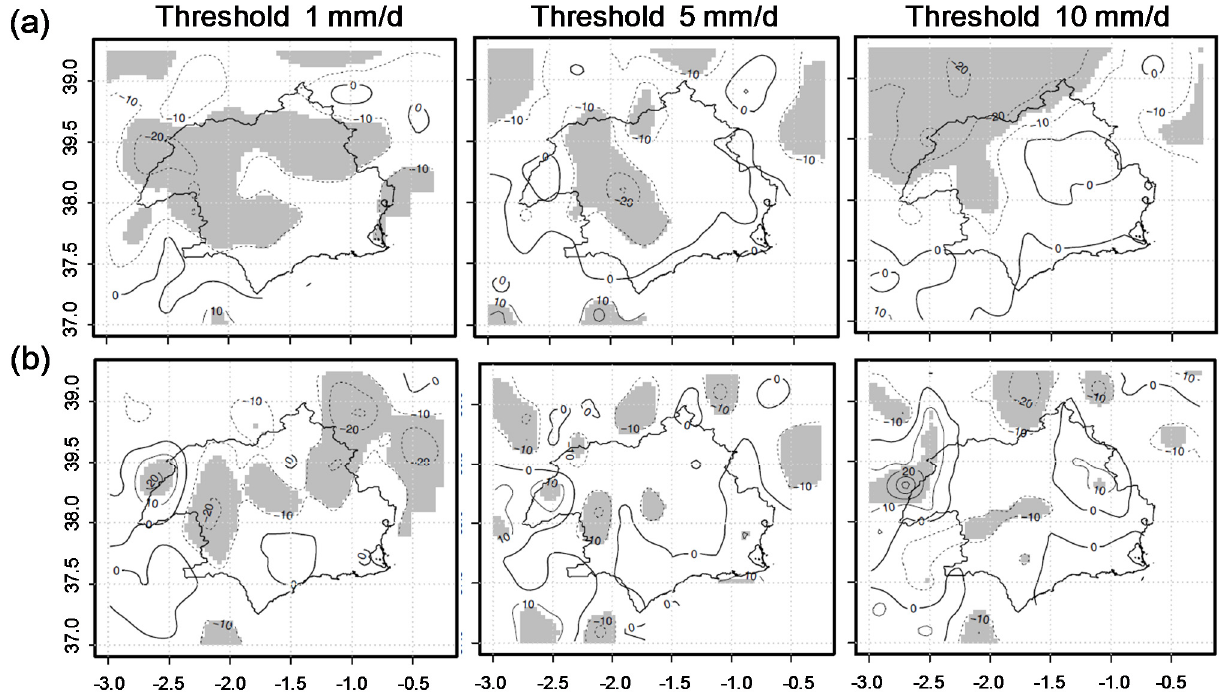
Figure 10. Spatial pattern of differences (Dif %) of MDSL, from GAMLSS analysis on each site for Tr = 2 years and thresholds: ( a ) Dif % (1980–1950)/1950; ( b ) Dif % (2007–1980)/1980. Dashed lines represent negatives values. Sites in solid gray, represent significant